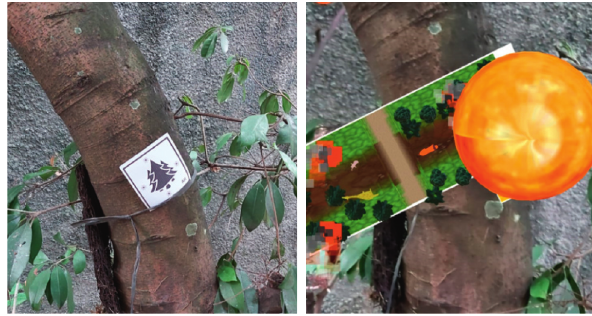
Figure 10: AR pinned on the